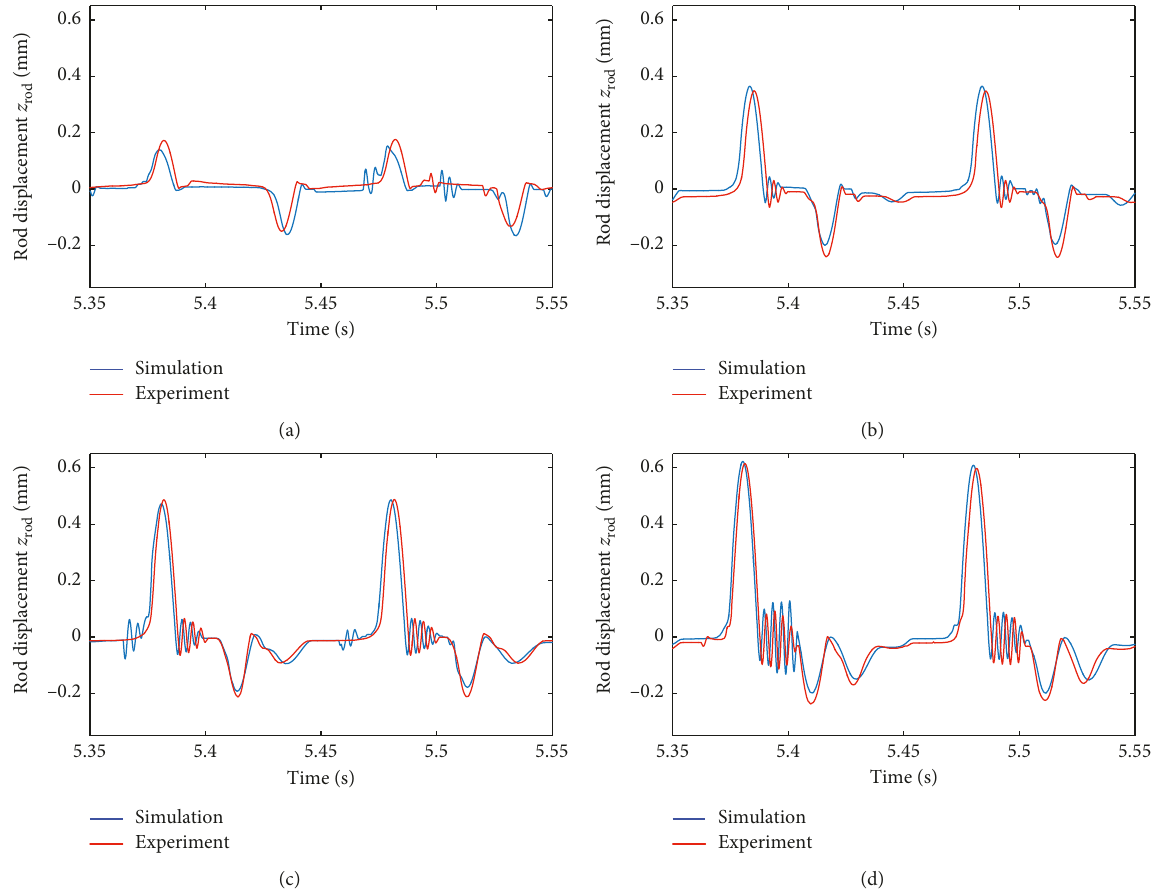
Figure 23: Displacements z (c) F max � 3 kN, and (d) F max � 4kN.